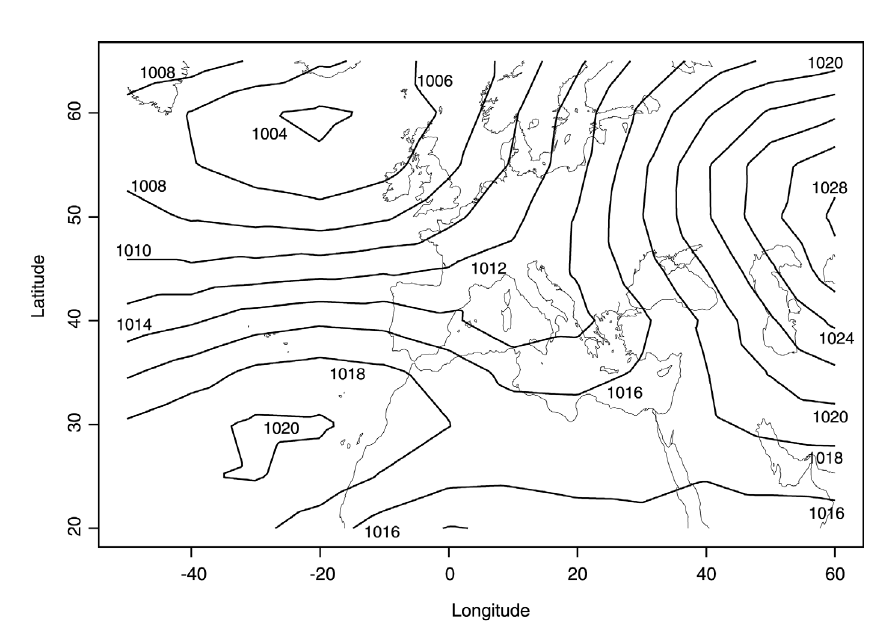
Fig. 5a. The mean winter pressure map associated with the six highest canonical function years (precipitation in the west, dry in the east). All contours labelled in